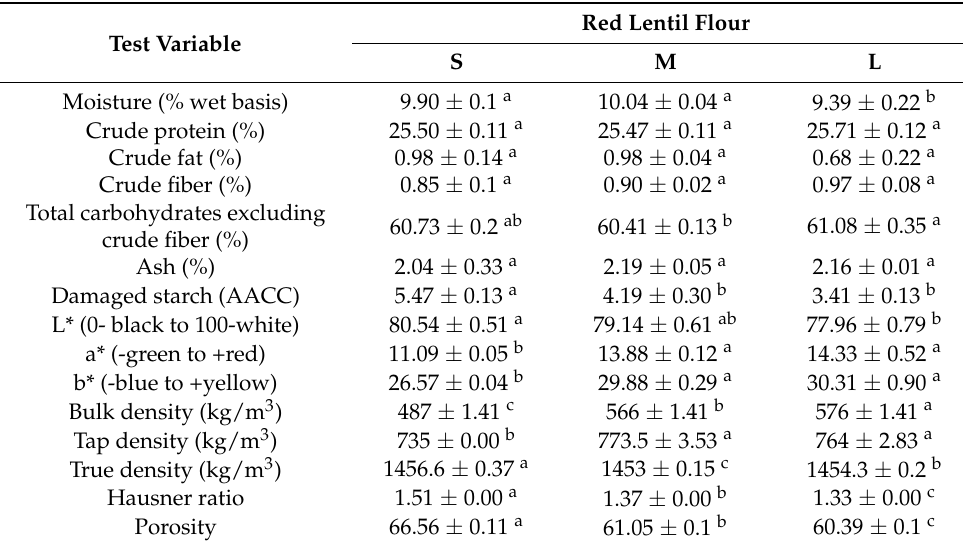
Table 4. Physicochemical properties of red lentil